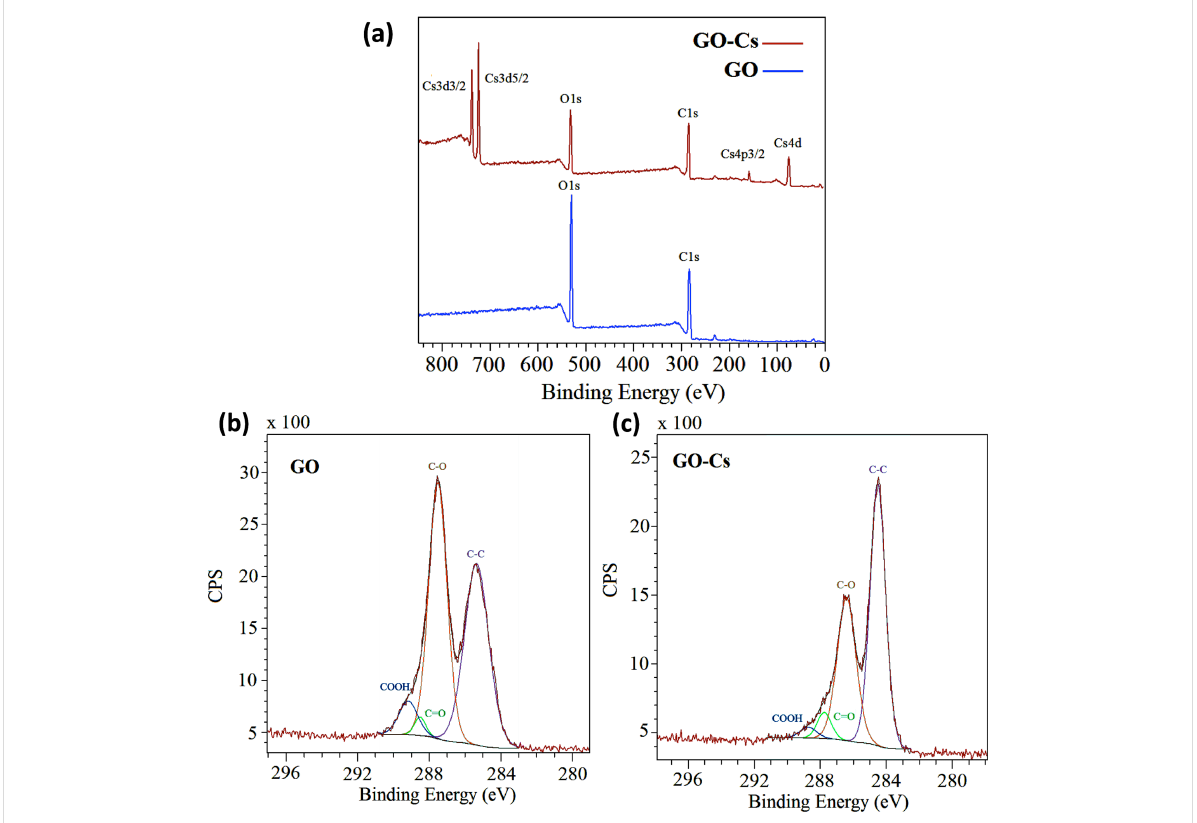
Figure 3: (a) XPS survey spectrum of GO (blue line) and GO-Cs (red line); High resolution XPS C1s spectra of (b) GO and (c) GO-Cs. The ≈ 1 eV shift towards lower binding energy of the peaks in (c) is due to the shift of the Fermi level caused by the doping.